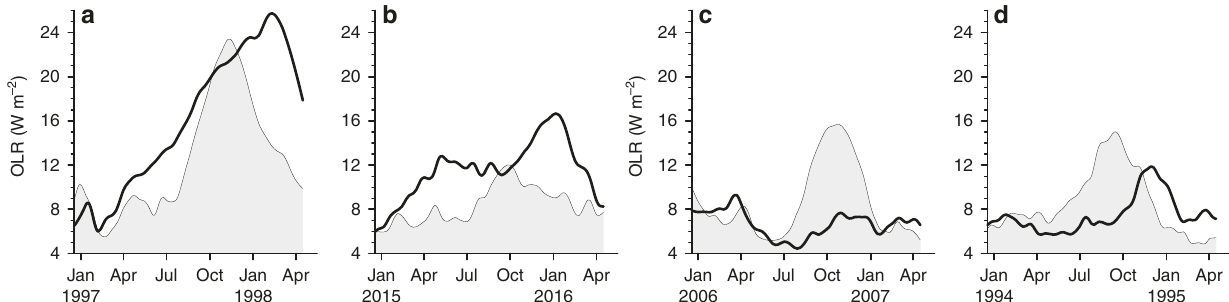
Fig. 4 Amplitude of convective variations during selected IOD and El Niño events. The shaded curve shows root mean amplitude of squared outgoing longwave radiation (OLR) anomaly over the Indian Ocean for a 1997, b 2015, c 2006, and d 1994; the solid lines are the same, but for the Paci fi c Ocean. We used daily anomalies that were were low-pass fi ltered to retain only periodicities longer than 90 days. At each grid point, these anomalies were squared. Then, their area averages were computed over the tropical (20°S – 20°N) Indian (40°E – 120°E) and Paci fi c (140°E – 280°E) Oceans — the square root of these areal averages is shown. During ENSO and IOD events, convective anomalies are not of a single sign, neither over the tropical Paci fi c Ocean, nor over the tropical Indian Ocean. For example, a positive IOD event is associated with negative OLR anomaly over the central tropical Indian Ocean and positive OLR anomaly over the eastern tropical Indian Ocean. The use of squared OLR anomalies capture the amplitude of both phases of OLR variations during IOD or ENSO events in a single OLR